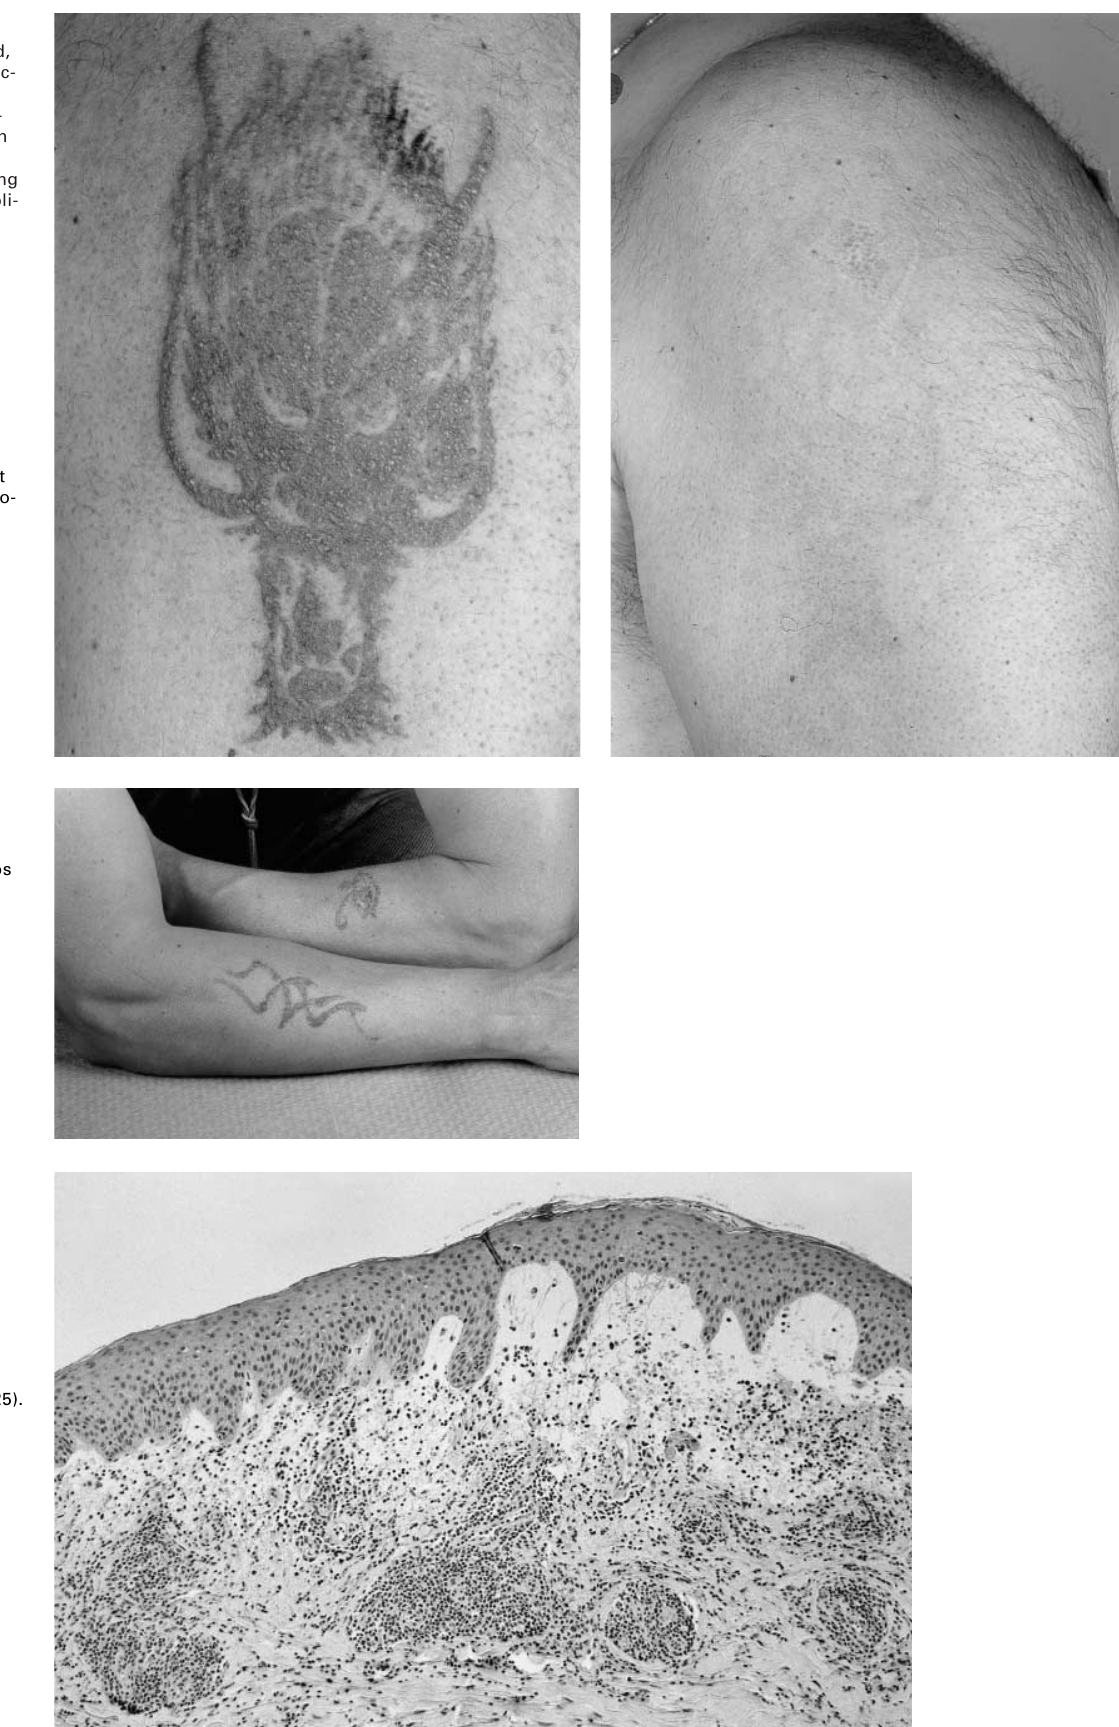
Sharply demarcated, papulovesicular reac- tion following the borders of a tempo- rary henna tattoo on the shoulder of pa- tient No. 1, appearing 2 days after the appli- cation of a second tattoo.